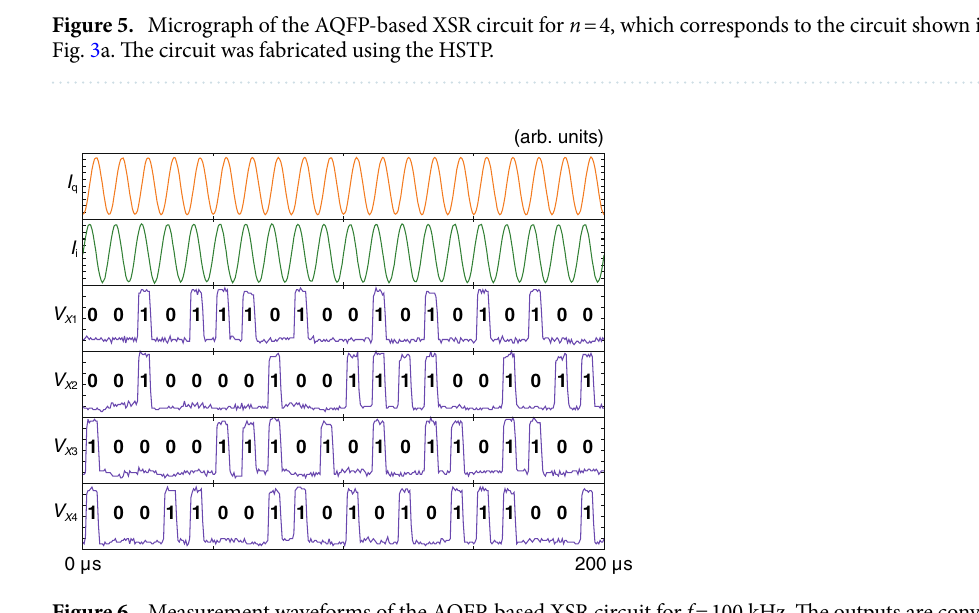
Figure 6. Measurement waveforms of the AQFP-based XSR circuit for f = 100 kHz. The outputs are converted into the corresponding voltage signals ( V X 1 through V X 4